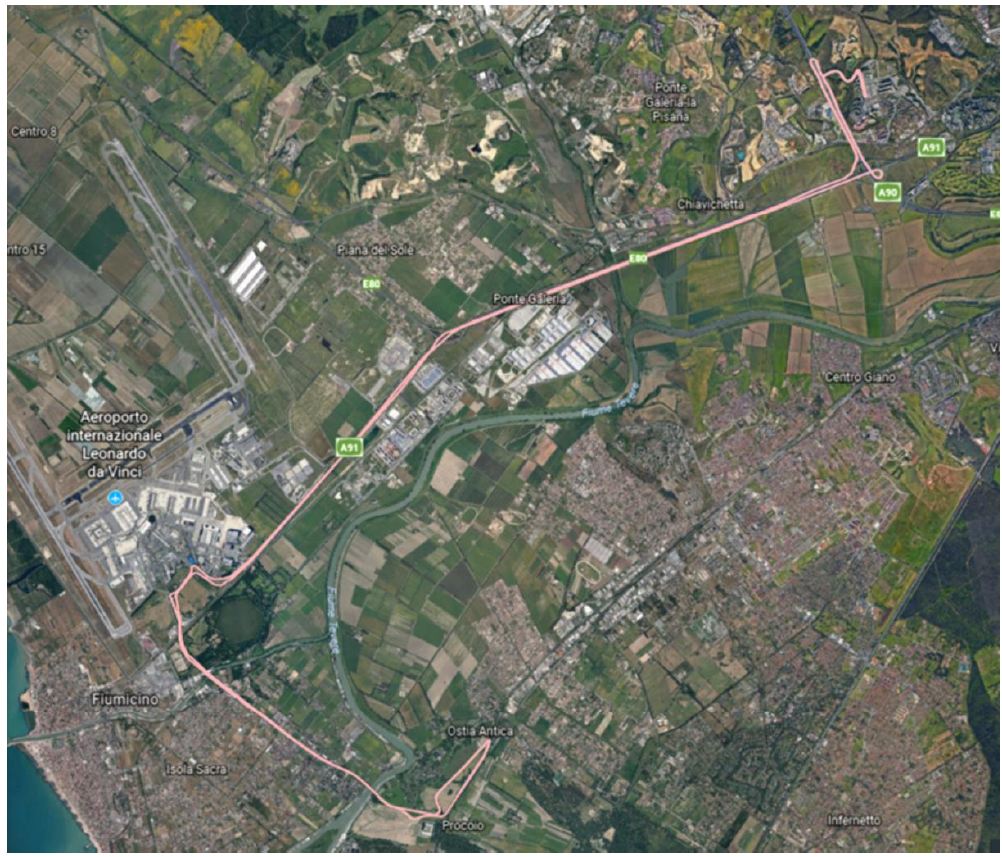
Figure 5. Extra-urban—highway sections.